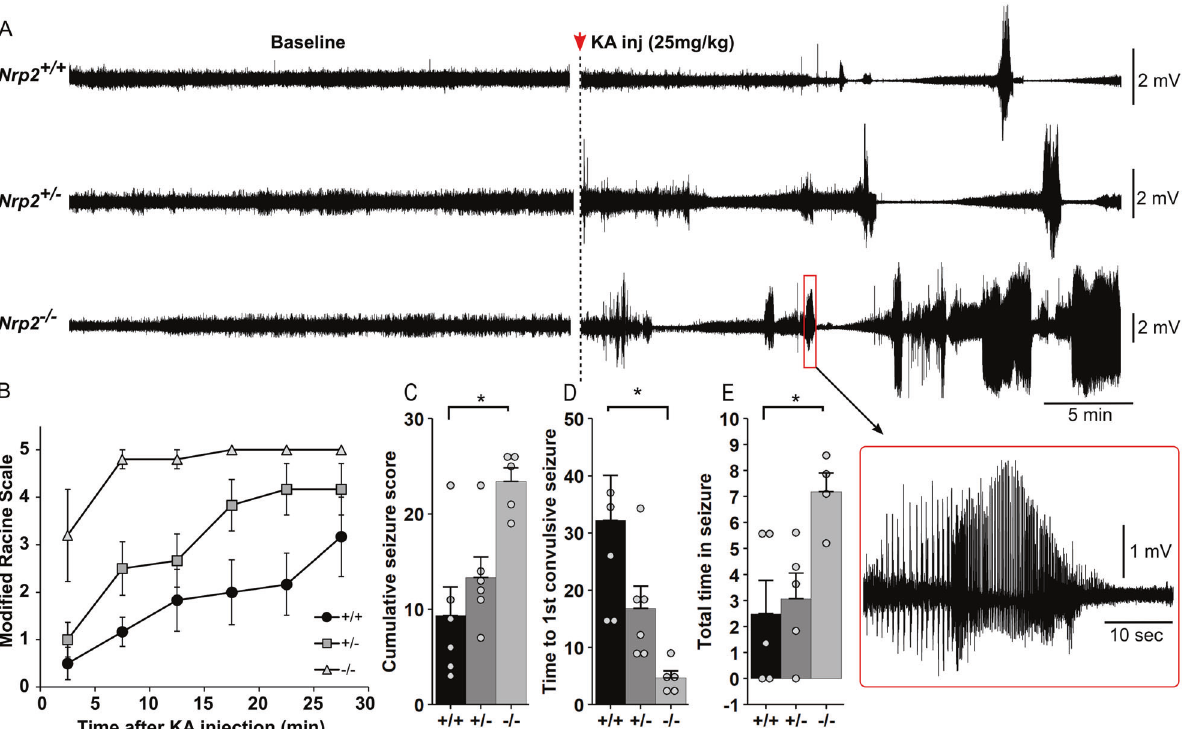
Fig. 6 Increased susceptibility to chemically induced seizures in mice lacking Nrp2. A Representative baseline EEG traces (left) and EEG traces following KA injection (right) show development of electrographic seizures in Nrp2 + / + (top), Nrp2 + / − (middle), and Nrp2 − / − (bottom) mice during the fi rst 30 min following injection of Kainic acid (25 mg/kg). B Latency to fi rst convulsive seizure following KA inj. Note that Nrp2 − / − mice ( n = 5) develop convulsive seizures signi fi cantly faster than Nrp2 + / − ( n = 6), Nrp2 + / + ( n = 6) mice. C Cumulative seizures